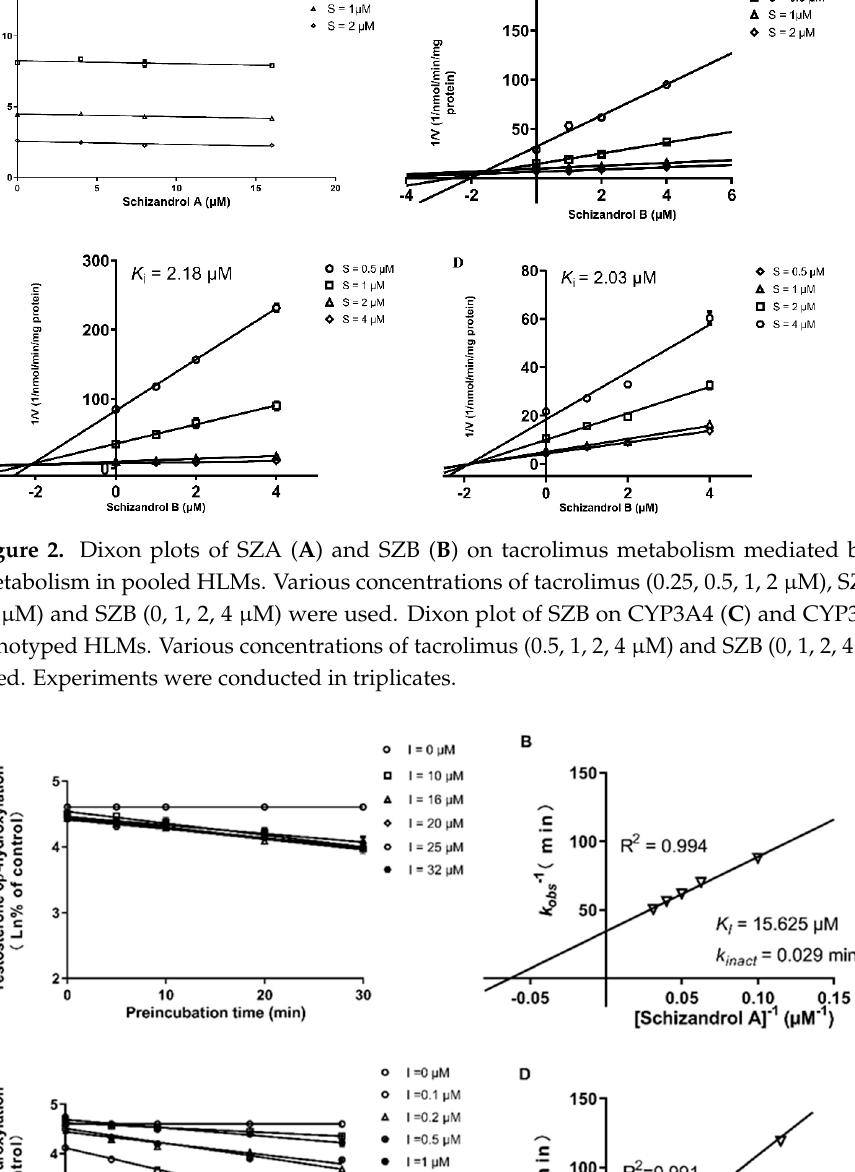
Figure 4 . Dixon plots of SZA on CYP3A4 ( A , B ) and CYP3A5 ( C ) inactivation in genotyped HLMs. Various concentrations of SZA (0, 10, 16, 20, 25, 32 μ M for CYP3A4 and 0, 10, 20, 30, 40, 50 μ M for CYP3A5) were pre-incubated at 3 °C for 0, 5, 10, 20 and 30 min in 0.1 M PBS. ( A , C ) were plotted with the log of the percentage of control activity versus preincubation time. ( B ) was plotted with the half-life of enzyme inactivation versus the inverse of the SZA concentration. Each point repre- sents the mean of triplicate experiments.